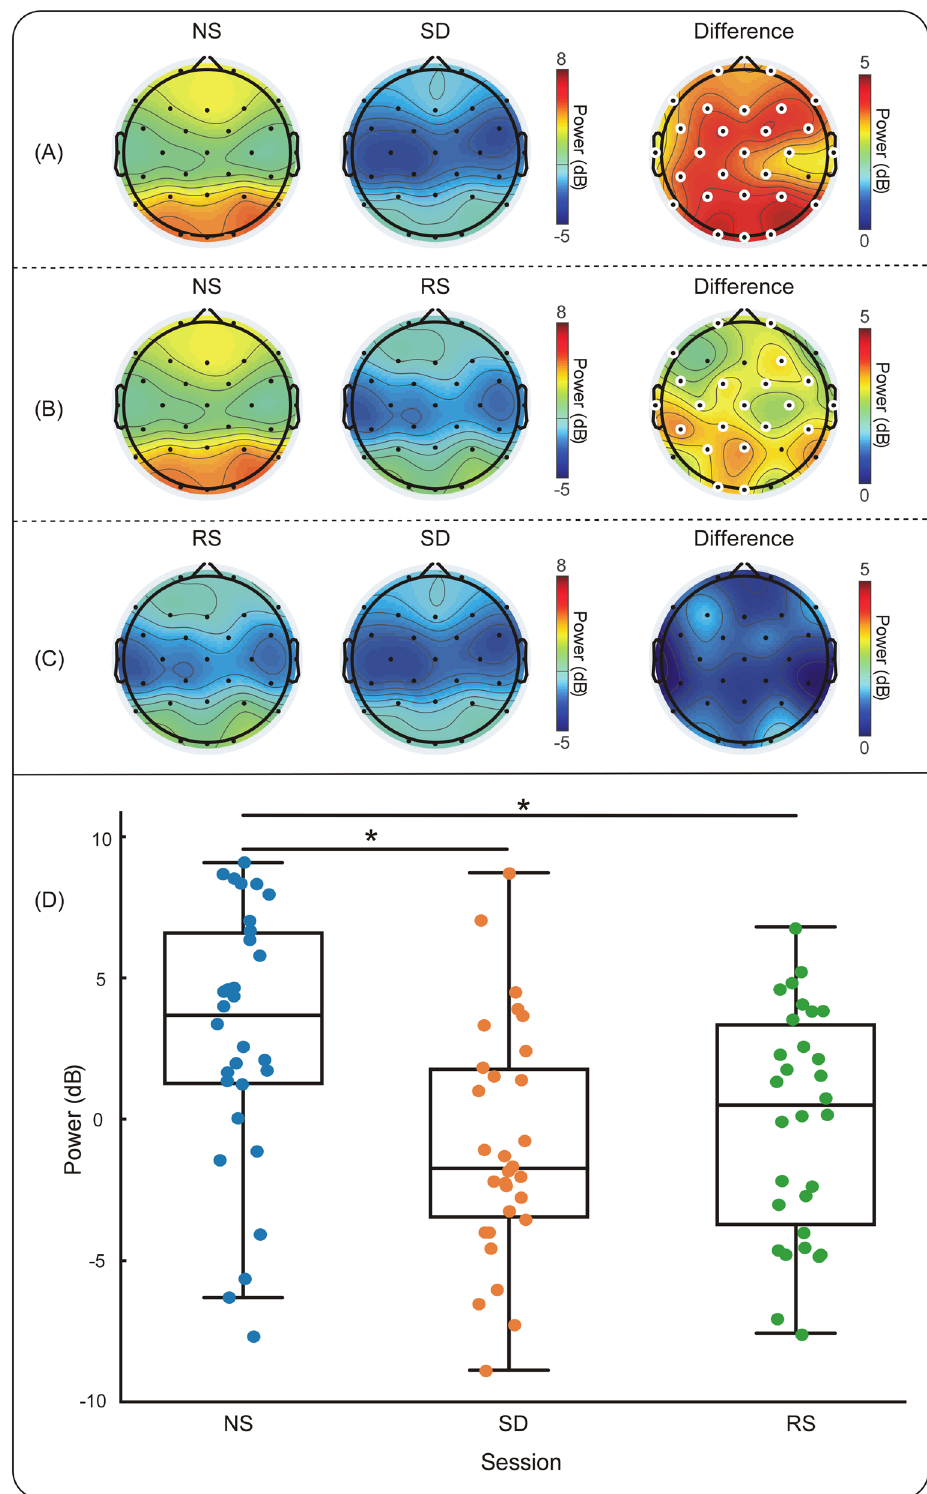
Figure 1. Alpha power differences. ( A ) Topographical distribution of NS and SD sessions. ( B ) Topographical distribution of NS and RS sessions. ( C ) Topographical distribution of RS and SD sessions. ( D ) Variability of the average power spectrum of the whole brain across subjects in the three sessions (NS vs. SD vs. RS, mean ± standard deviation: 3.133 ± 4.718 dB vs. − 0.771 ± 4.223 dB vs. 0.068 ± 4.061 dB). * p < 0.05. Enlarged white circles represent electrodes with significant differences. Abbreviations: NS, normal sleep; SD, sleep deprivation; RS, recovery